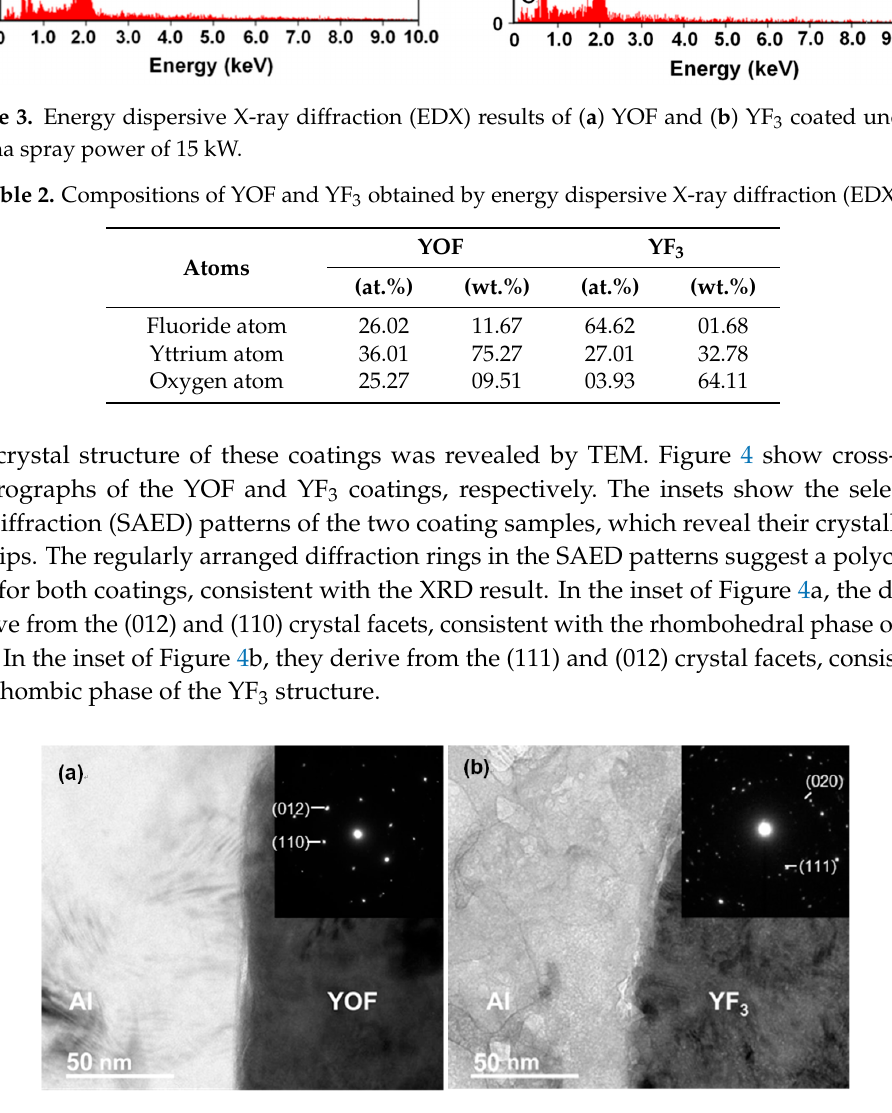
Figure 4. Cross-sectional transmission electron microcopy (TEM) images of ( a ) YOF and ( b ) YF 3 coated under a plasma spray power of 15 kW.